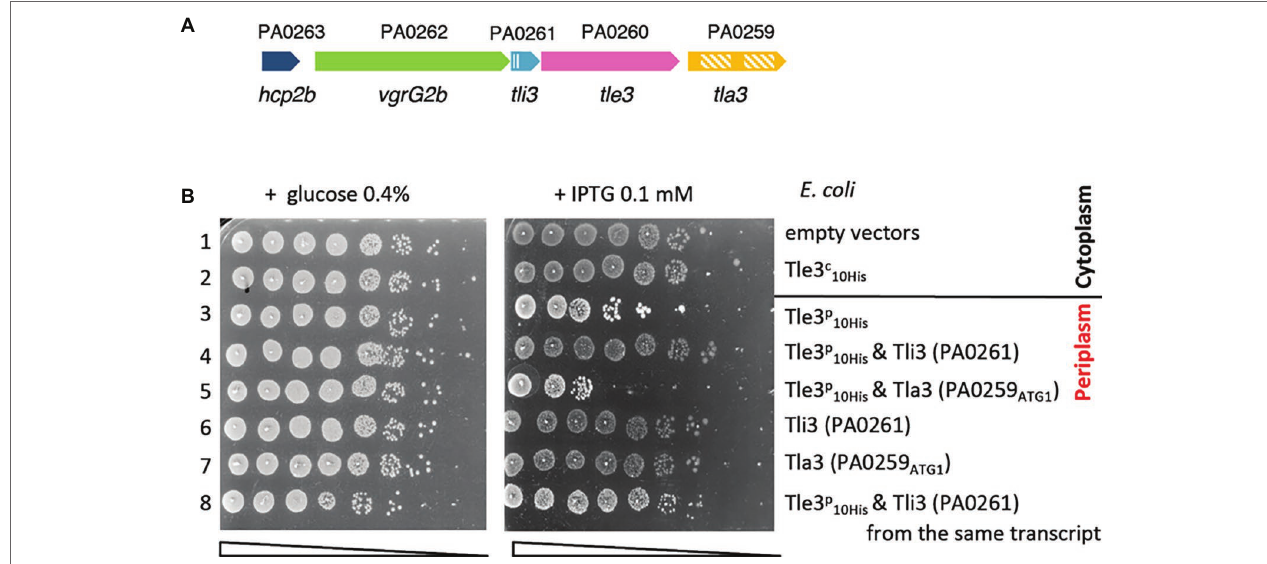
FIGURE 1 | (A) vgrG2b island organization. The genes are labeled with the given name (i.e., hcp2b ) and are indicated by their annotation number (e.g., PA0263). The Sec signal peptide of Tli3 (PA0261) and the two DUF2875 of Tla3 (PA0259) are represented with stripped boxes. (B) The Tle3 periplasmic toxicity is counteracted by Tli3 (PA0261). Serial dilutions (from non-diluted to 10 −7 ) of normalized cultures of E. coli BL21(DE3)pLysS producing the wild-type Tle3 in the cytoplasm, called Tle3 c (from pVT1, a pETDuet-1 derivative) or in the periplasm, called Tle3 p [from pSBC81, a pET22b(+) derivative yielding a fusion of Tle3 with a Sec signal peptide] were spotted on LB agar plates supplemented (left panel) with 0.4% glucose or (right panel) with 0.1 mM IPTG. Glucose and IPTG allow respectively repression and induction of the gene encoding the T7 RNA polymerase. When indicated Tli3 (PA0261) or Tla3 (PA0259) were produced in the periplasm from pVT8, pSBC107 and pVT9, respectively, pRSFDuet-1 derivatives. Line 1: pET22b(+) and pRSFDuet-1, line 2: pVT1 and pRSFDuet-1, line 3: pSBC81 and pRSFDuet-1, line 4: pSBC81 and pVT8, line 5: pSBC81 and pVT9, line 6: pVT8 and pET22b(+), line 7: pVT9 and pET22b(+), and line 8: pSBC107 is a pRSFDuet-1 derivative producing Tli3 (PA0261) and Tle3 p from the same